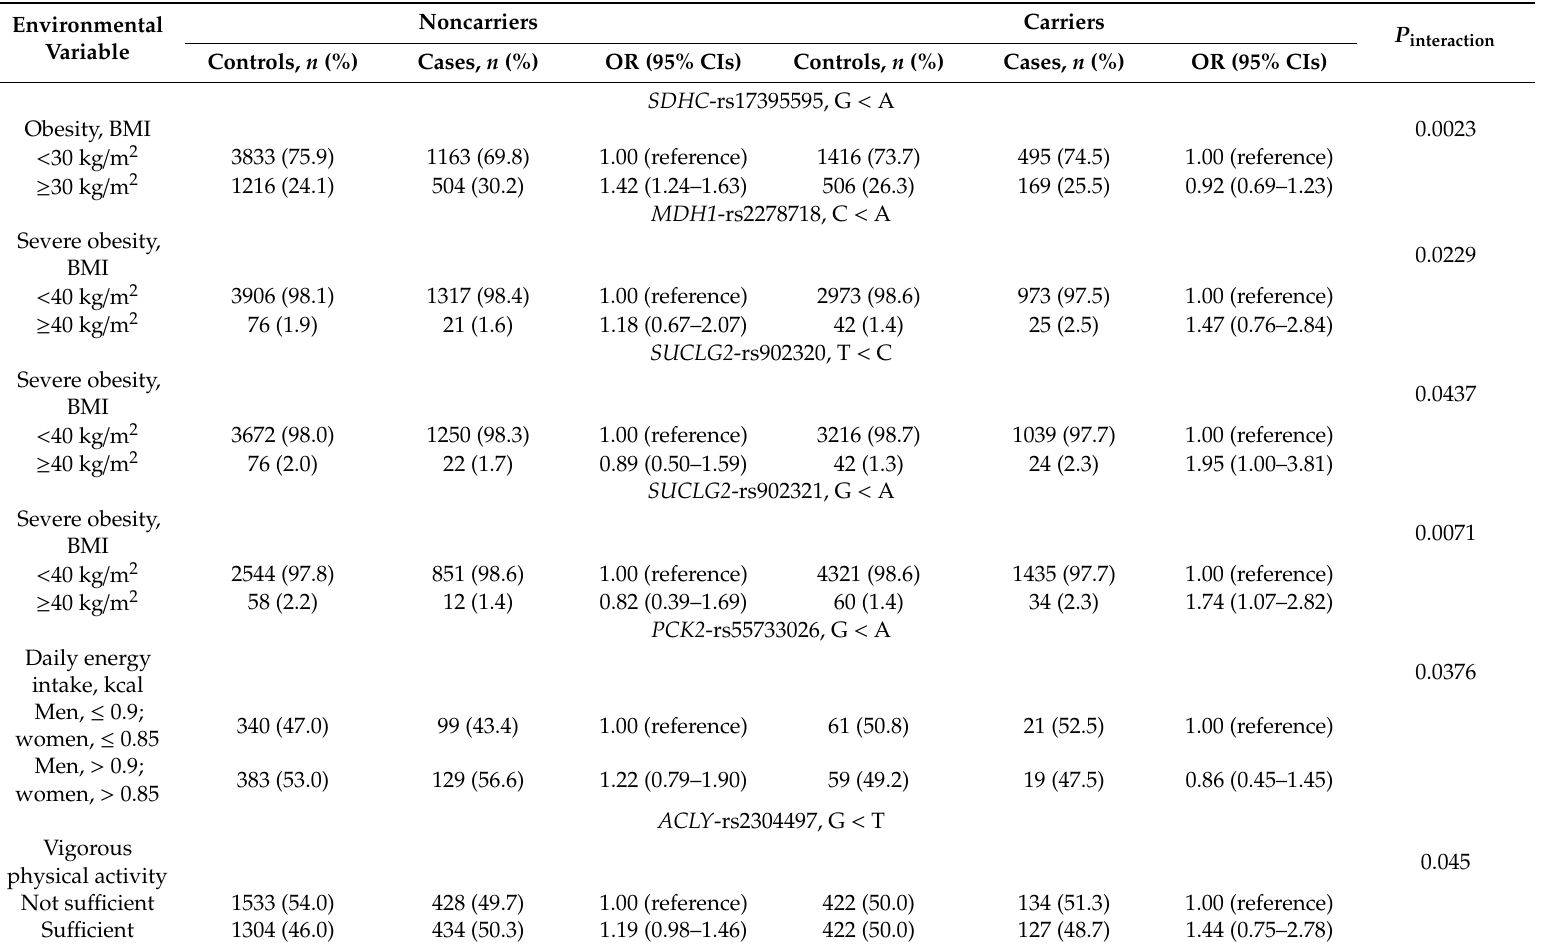
Table 4. Odds ratios (OR) and 95% confidence intervals (CIs) for the contributors of energy balance on the risk of colon cancer by noncarriers or carriers of the citric acid cycle SNPs showing an interaction p -value under